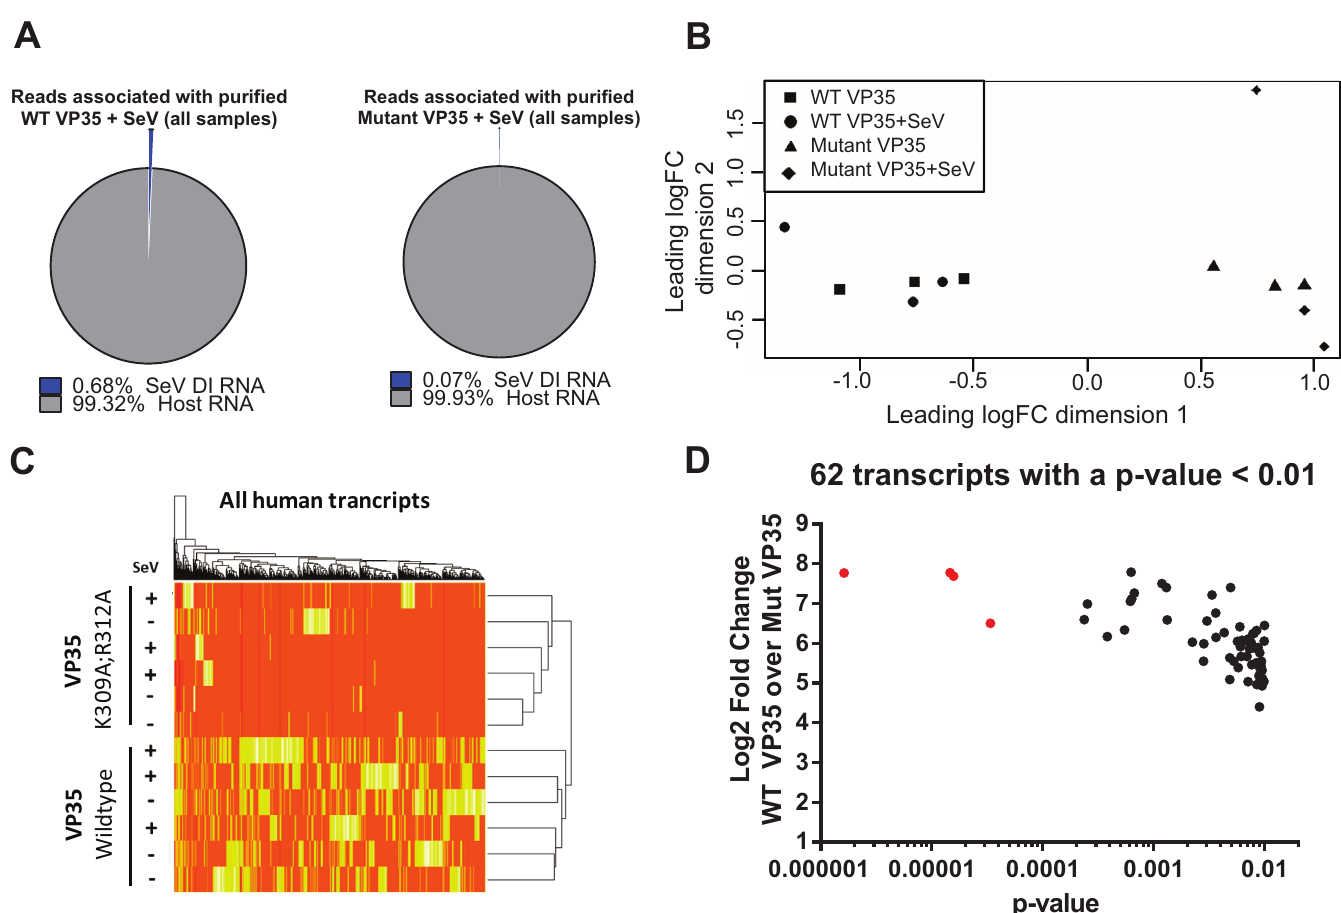
Fig 4. An analysis of host RNAs highlights transcripts bound by VP35. (A) Total number of sequencing reads from triplicate samples of wildtype and mutant VP35 proteins infected in the SeV infected groups. The pie charts depict the percentage of reads that map to the SeV DI genome and the percentage of reads that do not map to the SeV DI. (B) Multidimensional scaling(MDS) plot of triplicate samples from wild-typeVP35 (black squares), wild- type VP35 infected with SeV (black circles), mutant VP35 (black triangle)and mutant VP35 infected with SeV (black diamond). Axes in the MDS plot (LeadinglogFC dim1 and Leading logFC dim2) are arbitrary, and the values on the axes are distanceunits. (C) Heat map showingthe bindingof the wild- type and mutant VP35 protein to human mRNA transcripts for all samples includedin the analysis. Each row represents an experimental replicate, and each column representsa single transcript. Colors indicate relative abundance for each gene, where orangeis low abundance and white is high abundance. (D) Sorting of the 62 most statistically significantly enriched mRNAs associatedwith VP35 (from the mock-infected wild-typeVP35 samples). Y-axis denotes the p-value of each sample and X-axis denotesfold-change of transcript abundancebetweenwild-typeand mutant VP35.